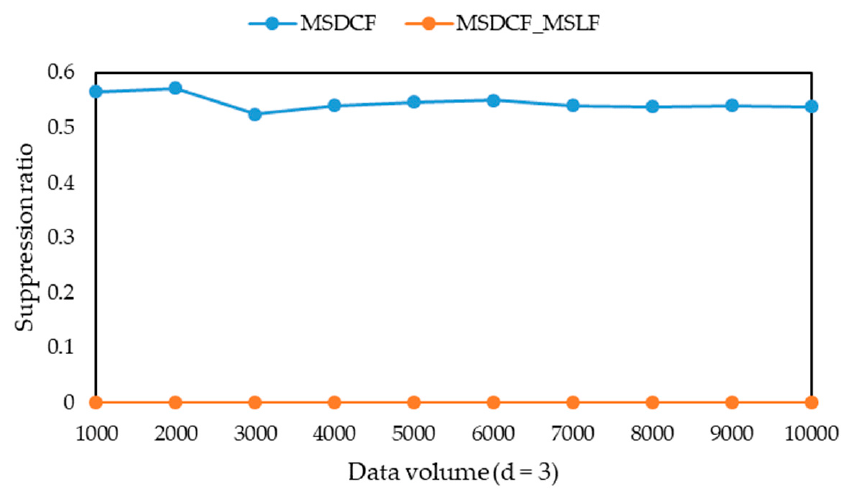
Figure 9. The suppression ratio of MSDCF and MSDCF-MSLF with different data volumes ( d = 3).